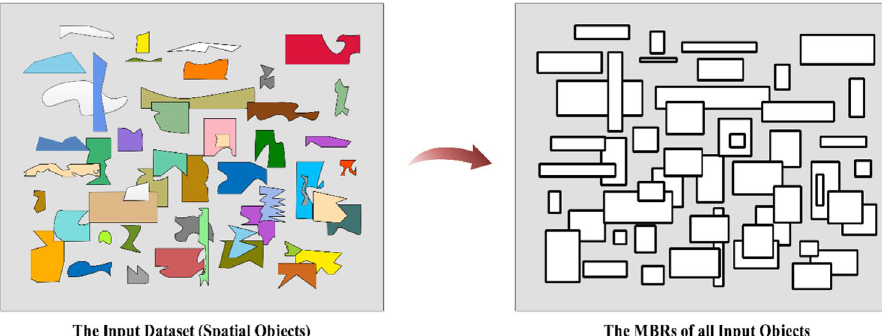
Fig. 7 One-tier process of approximating a virtual input spatial dataset into a set of Minimum Boundary Rectangles